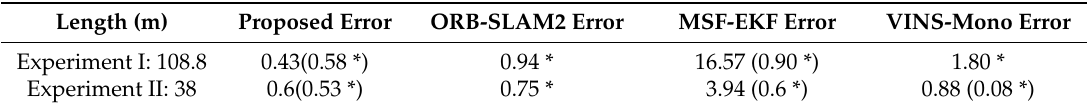
Table 1. RMSE (m) of motion estimation in different methods. (Value marked with an asterisk (*) was obtained before VO failure.)